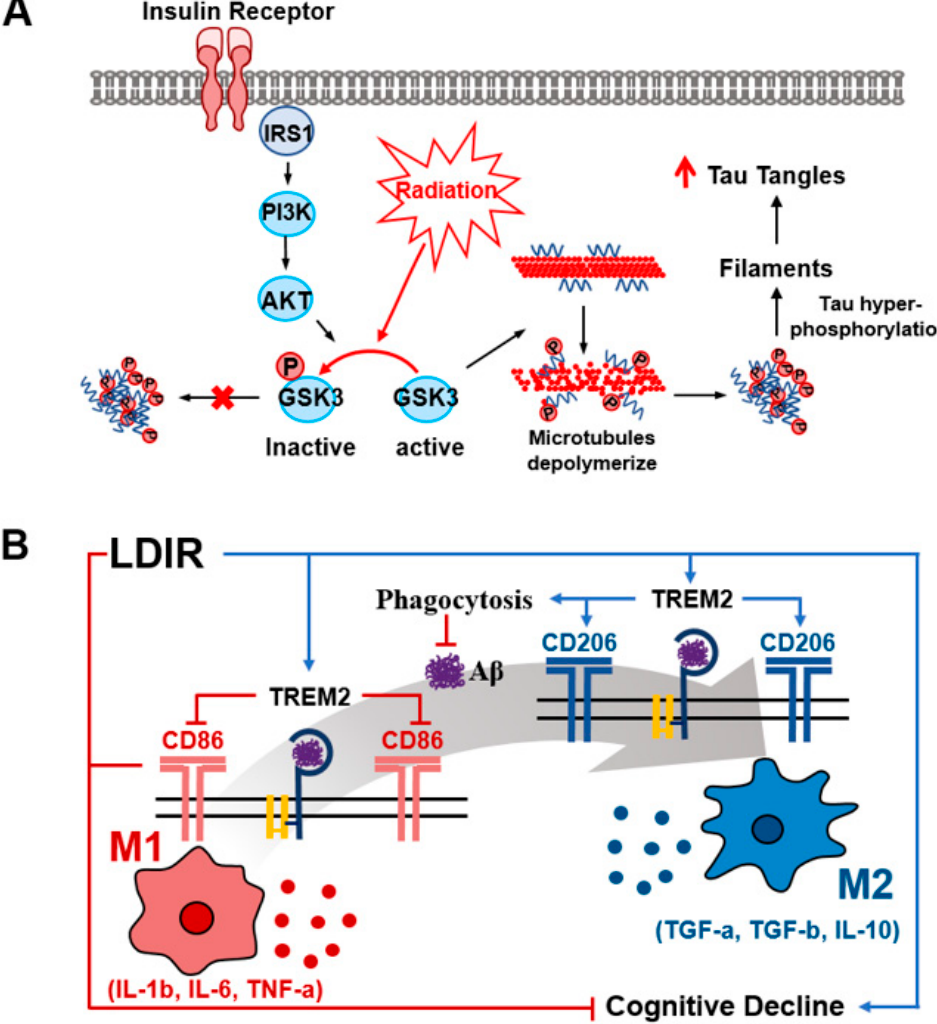
Figure 4. Schematic of signaling pathways and dose/time-dependent effects of ionizing radiation. ( A ) Schematic representation of irradiated dose-dependent biphasic effects at the molecular level. A high dose irradiation inhibits the activity of GSK ‐ 3 β , thereby decreasing the tau tangles. ( B ) Schematic representation of the modulatory effects of LDIR exposure on the shifting phenotype of the macrophage.